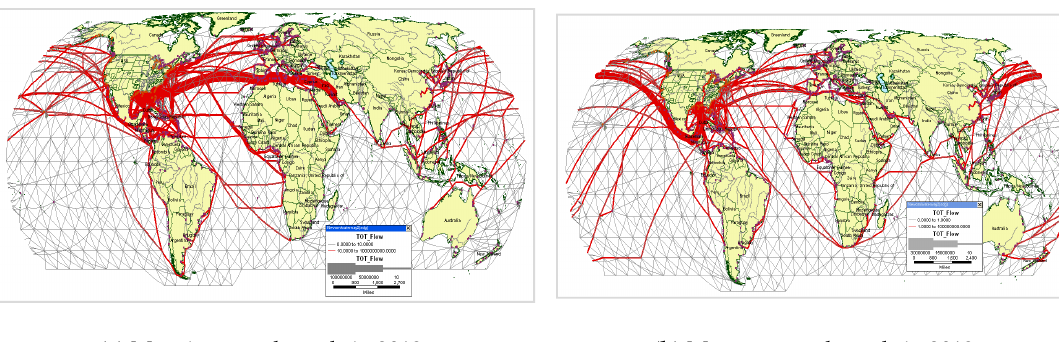
ISPRS Int. J. Geo-Inf. 2020 , x